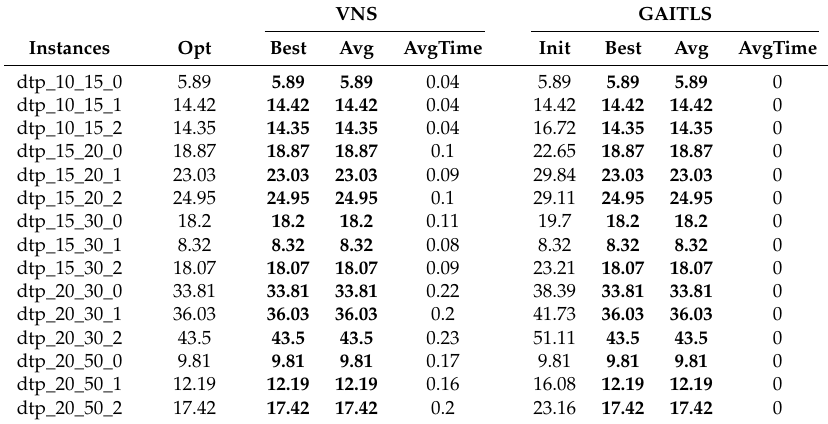
Table 1. Experimental results of VNS and GAITLS on small size instances of dtp.